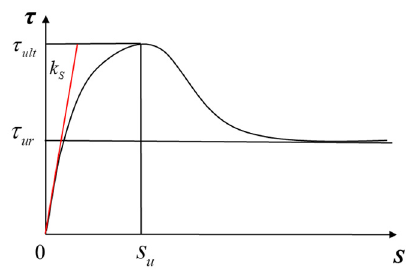
Figure 3. Piecewise function model for the near–pile soil.